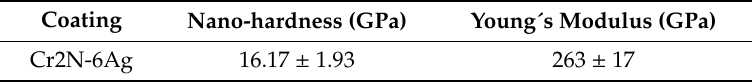
Table 4. Mechanical properties of the developed Cr 2 N–6Ag coating.